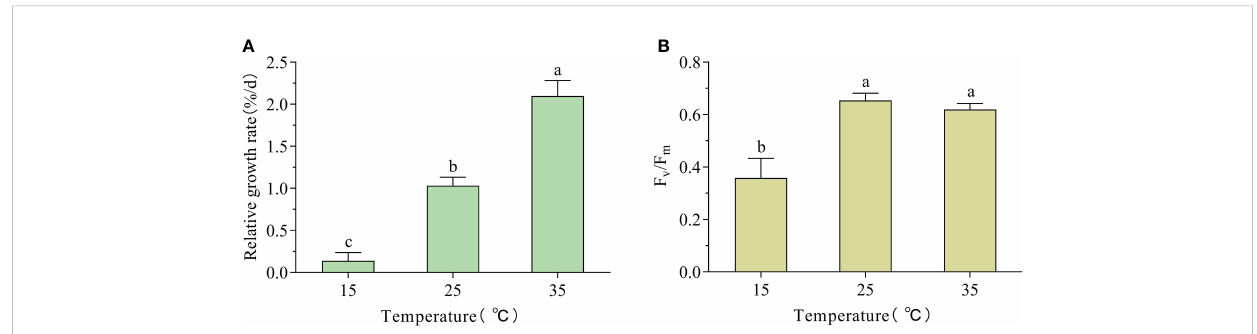
FIGURE 1 Relative growth rate (RGR) and F v /F m changes in G. bailinae exposed to different temperatures. (A) RGR. (B) Maximum photochemical quantum yield of PSII ( F v / F m ). Different small letters above the columns indicate a signi fi cant difference between different temperature treatments (P<